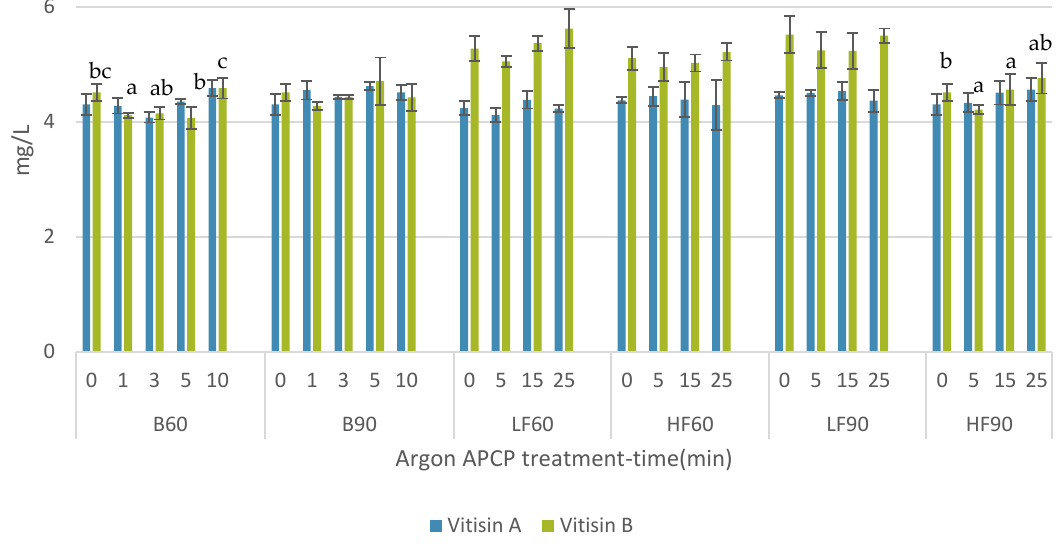
Figure 3. Vitisin A and B content (mg/L) in wine after different Argon – APCP treatments applied different times (0, 1, 3, 5, 10, 15, and 25 min). Error bars represent the standard deviation ( n = 3). Different letters mean significant differences between samples ( p ≤ 0.01). No letters mean no significant differences.